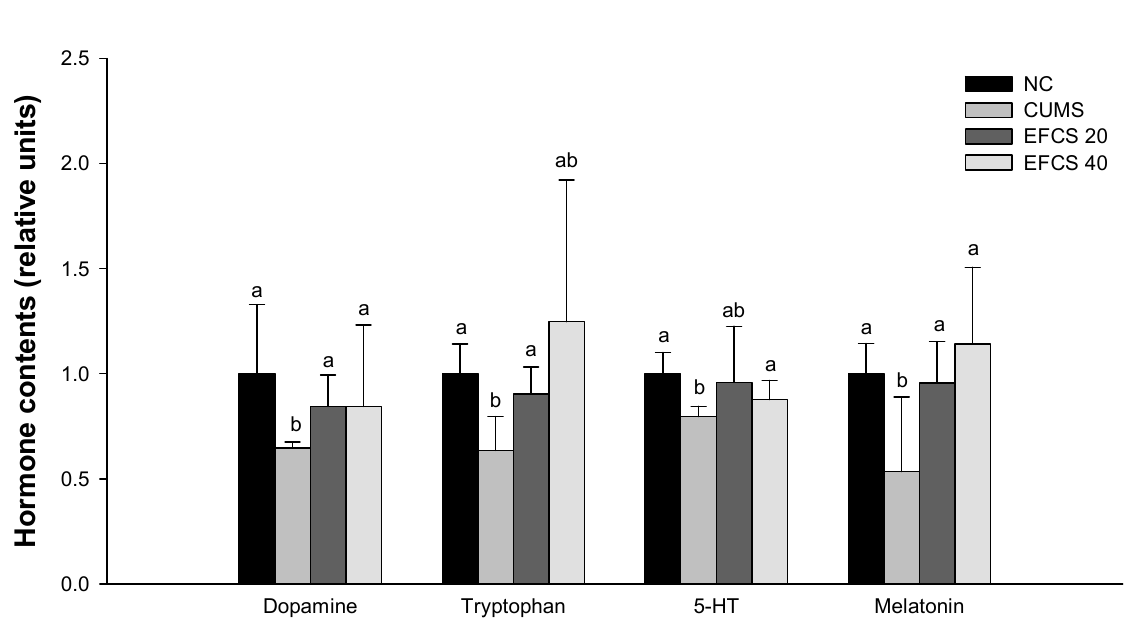
Figure 6. Effect of ethyl acetate fraction from Cedrela sinensis (EFCS) on dopamine, tryptophan, 5-HT, and melatonin contents in hypothalamus tissues. Results shown are mean ± SD ( n = 3). Data are statistically represented at p < 0.05, and different lowercase letters indicate statistical significance. Means with the same letter are not significantly different.